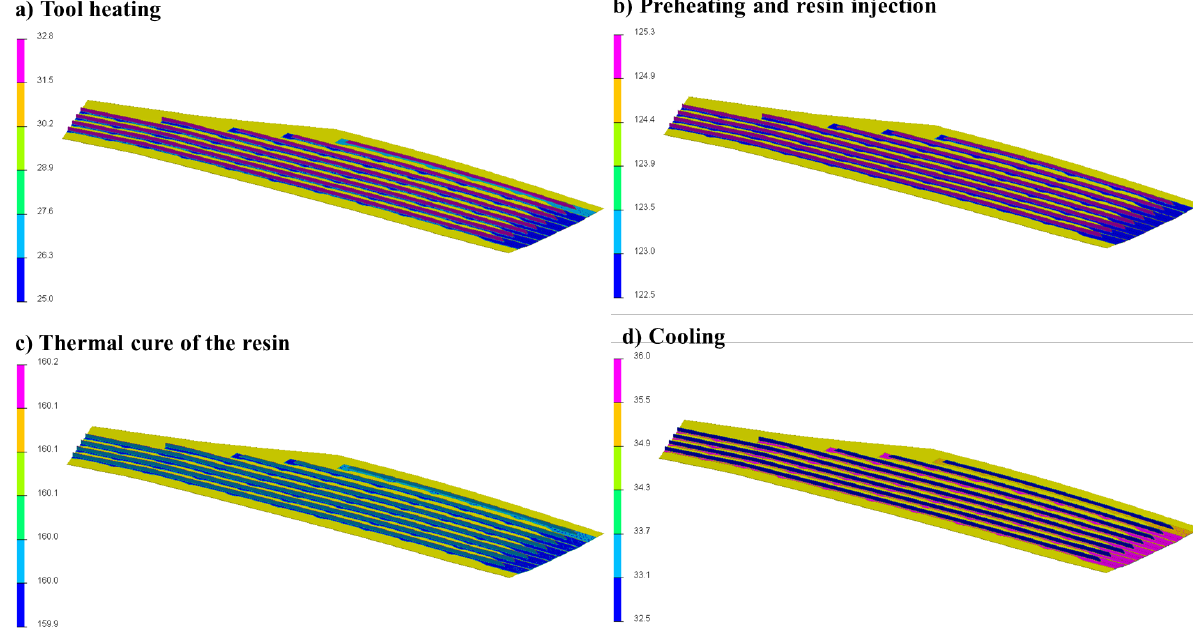
Figure 11: Thermal transfer simulations of all curing